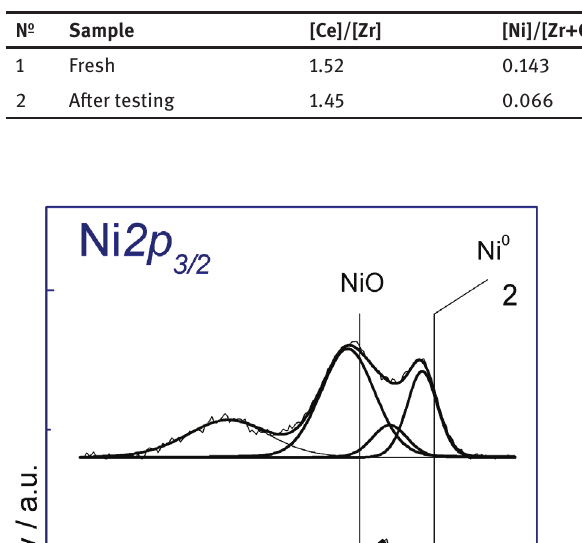
Table 3: Atomic ratio of elements in the surface layers.